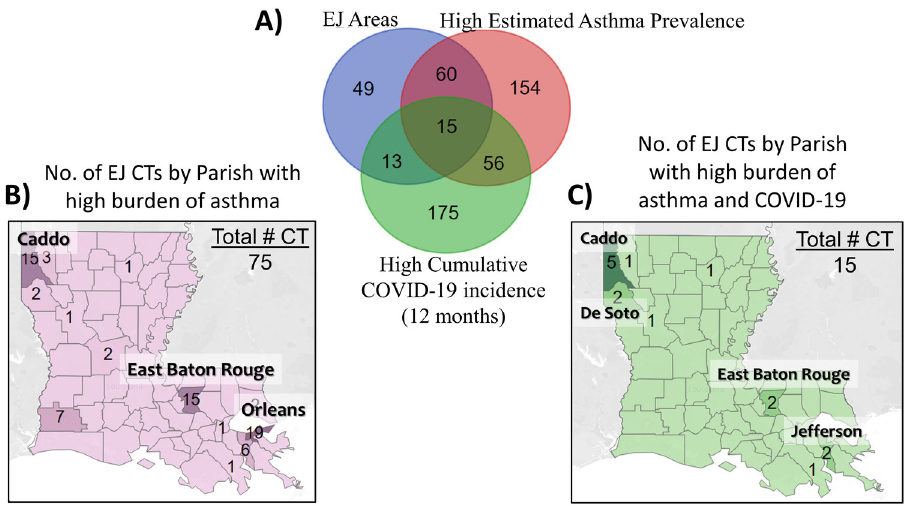
Fig 4. Identifying EJ communities with high COVID-19 and asthma burdens. (A) Of the 137 census tracts that were deemed of EJ concern, 75 (55%) had estimated prevalence of asthma at or above the 75 th percentile for the state. The majority of these CTs were located in the major urban areas, with others spread across the more rural areas of the state (B) . A similar pattern was observed for CTs that were of concern for EJ, asthma as well as COVID-19. About a third of the 15 EJ CTs deemed areas of concern for both asthma and COVID-19 were located in the northwestern part of the State in Caddo Parish (C)